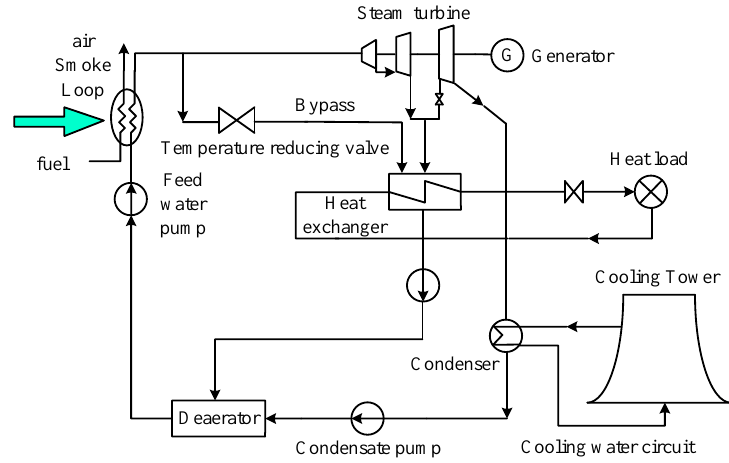
Figure 3. Structure diagram of the exhaust-type thermal power unit. This study analyzes the change of the electric heating characteristic curve of the unit after the heat storage device is added. As shown in Figure 4, the shaded part represents the feasible region for unit operation, and its characteristic curve expression is as follows.